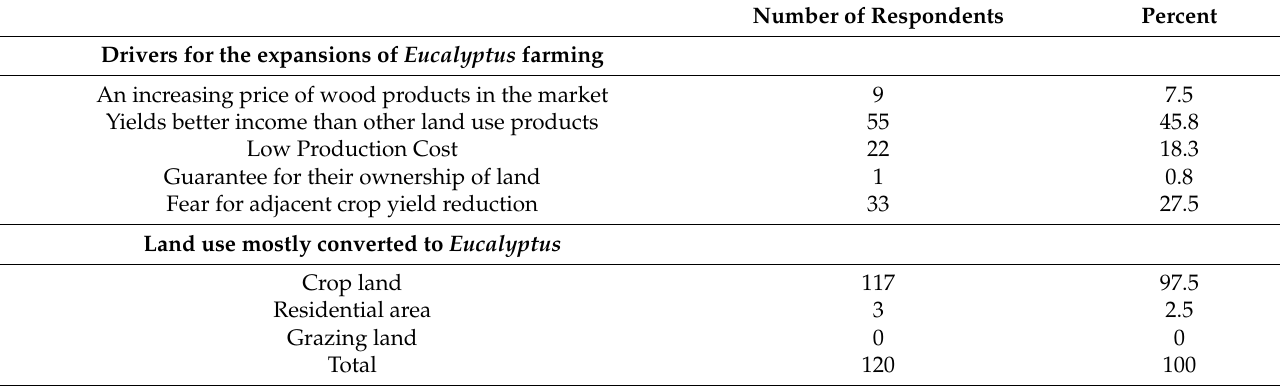
Table 5. Driving factors for expansions of Eucalyptus plantation.